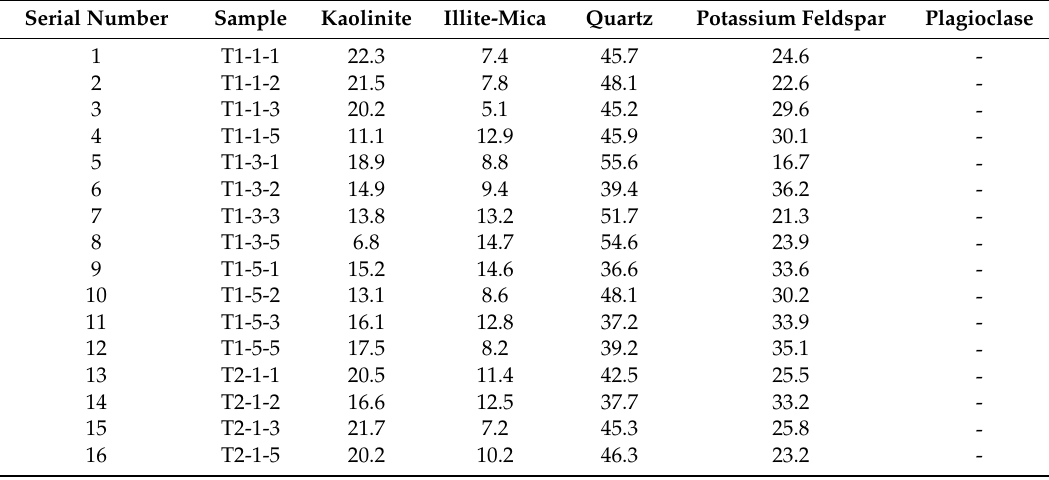
Table 4. Clay and other mineral content of eight soil profiles (T1 to T8) at di ff erent times during simulated leaching